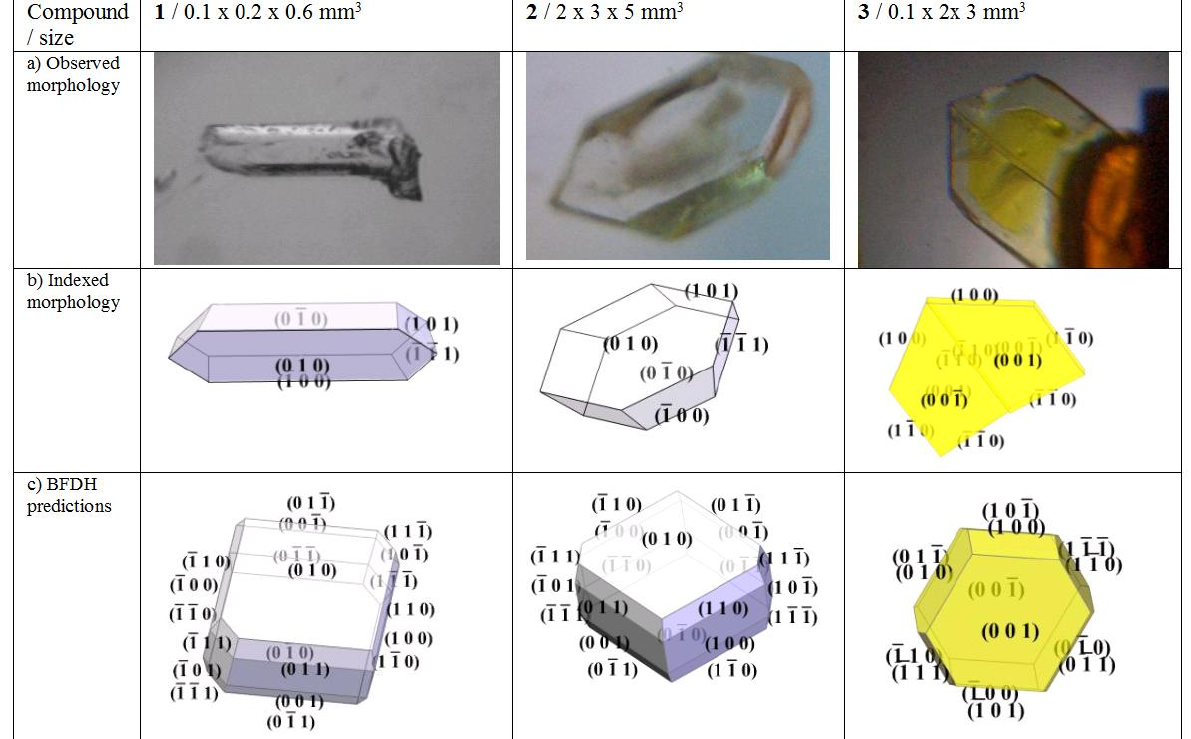
Figure 1. a) Photographs of idiomorphically grown specimen of 1 : N -(4-chlorophenyl)- N - [1( S )-1-phenylethyl]thiourea, 2 : N -(4-bromophenyl)- N -[1( S )-1-phenylethyl]thiourea, 3 : N - (4-nitrophenyl)- N -[1( S )-1-phenylethyl]thiourea. b) indexed morphologies. c)